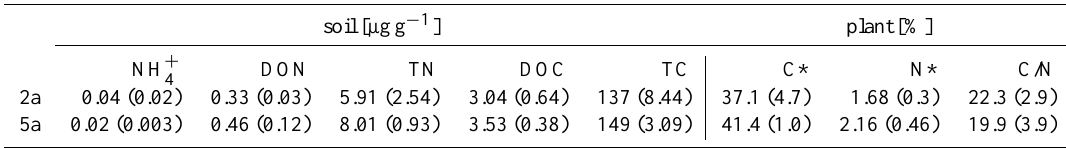
Table 1. Chemical parameters of bulk soil and plants. Dissolved organic carbon (DOC), dissolved organic nitrogen (DON), total carbon (TC) and total nitrogen (TN) contents were measured in bulk soil samples from the 2a and the 5a site ( n = 3, standard deviations in parenthesis). Plant carbon and nitrogen contents were measured in Trifolium arvense (L.) from the 2a and the 5a site ( n = 9, standard deviations in parenthesis). Nitrate concentration was below the detection limit for all samples ( < 0.3µgg − 1 ) . A significant impact of soil age on the measured parameters was tested with one-factor ANOVA ( p < 0.05) and indicated by an asterisk. soil [µgg − 1 ] plant [%]